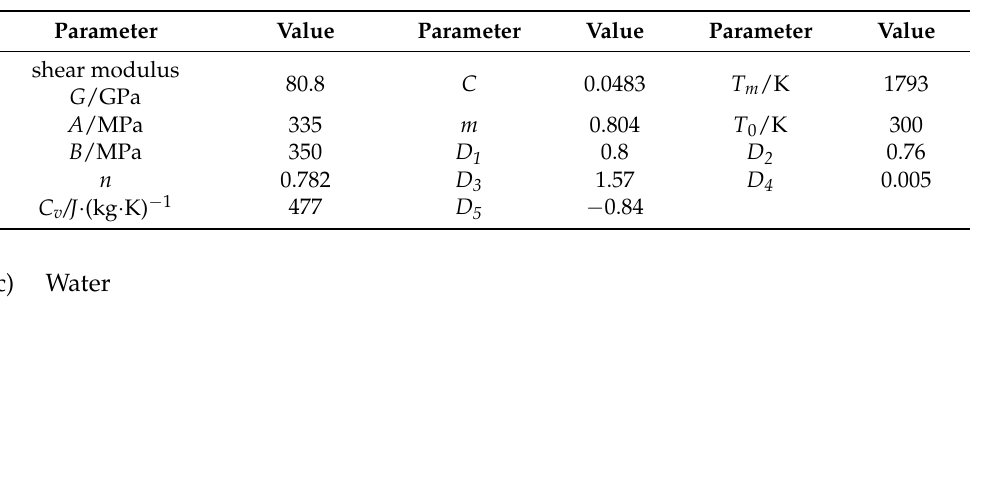
Table 3. Mechanical parameters of the